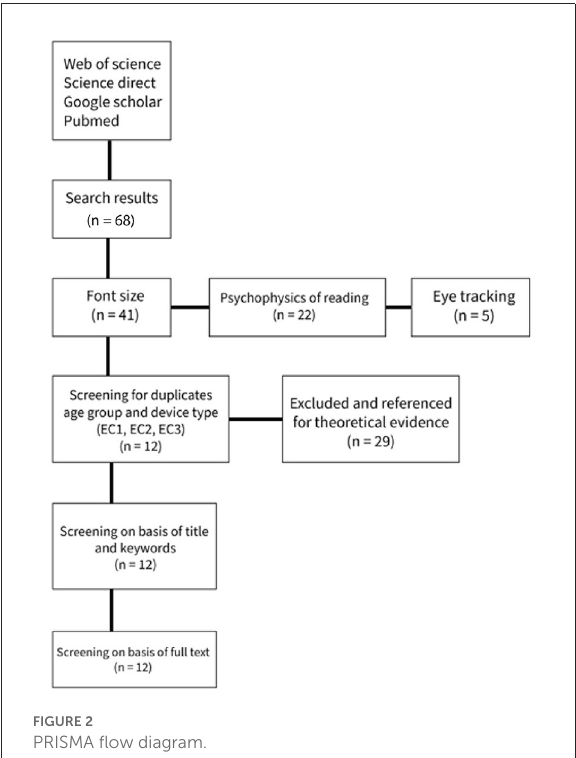
FIGURE2 PRISMA flow